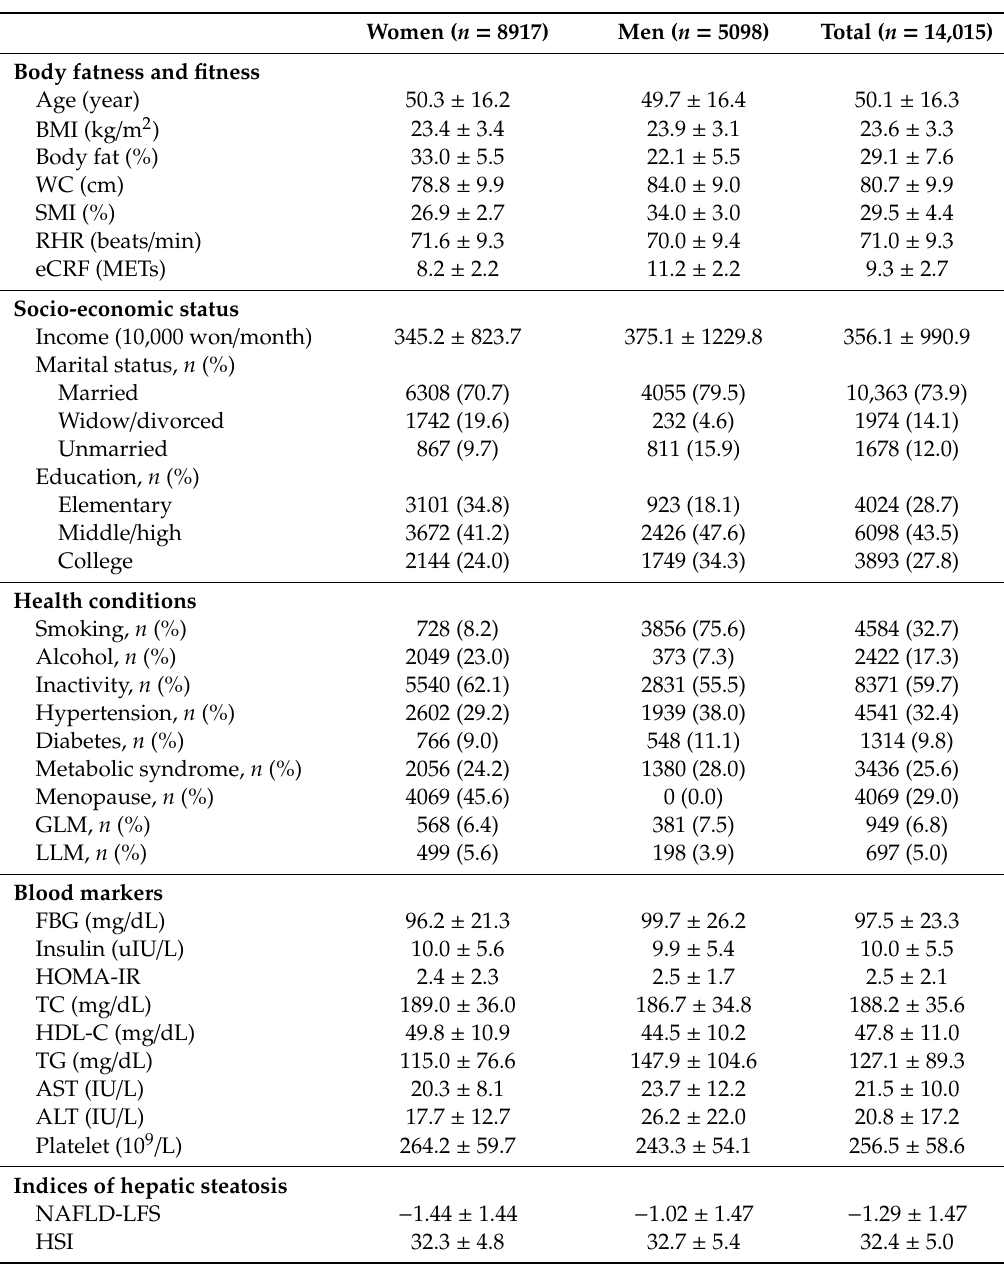
Table 1. Description of study